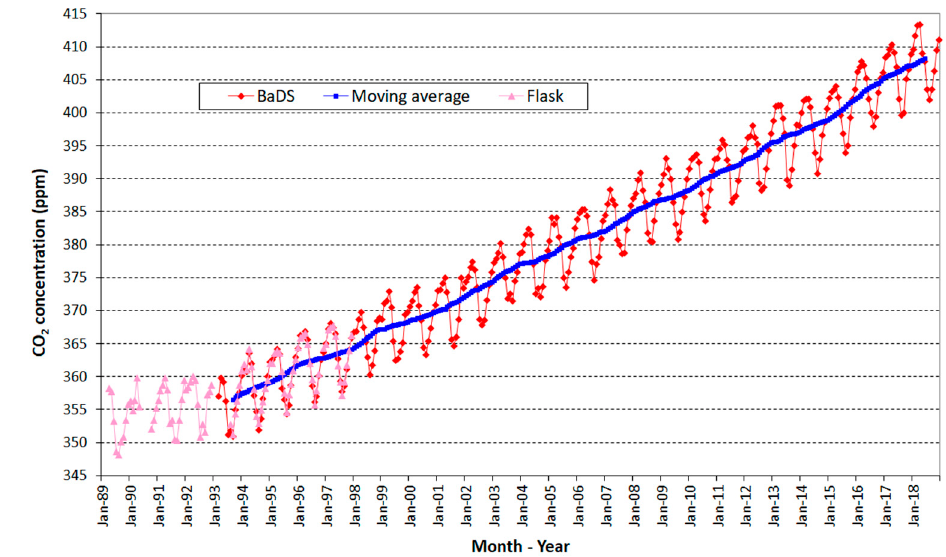
Figure 8. Historical series of monthly averages of the CO 2 background concentration gathered at Plateau Rosa by means of continuous measurements from March 1993 to December 2018 (red diamonds) and by means of weekly flask measurements from April 1989 to December 1997 (pink diamonds). The curve in the thick blue represents the centred moving average of an order of 12 of the background monthly values, applied only to continuous measurements.